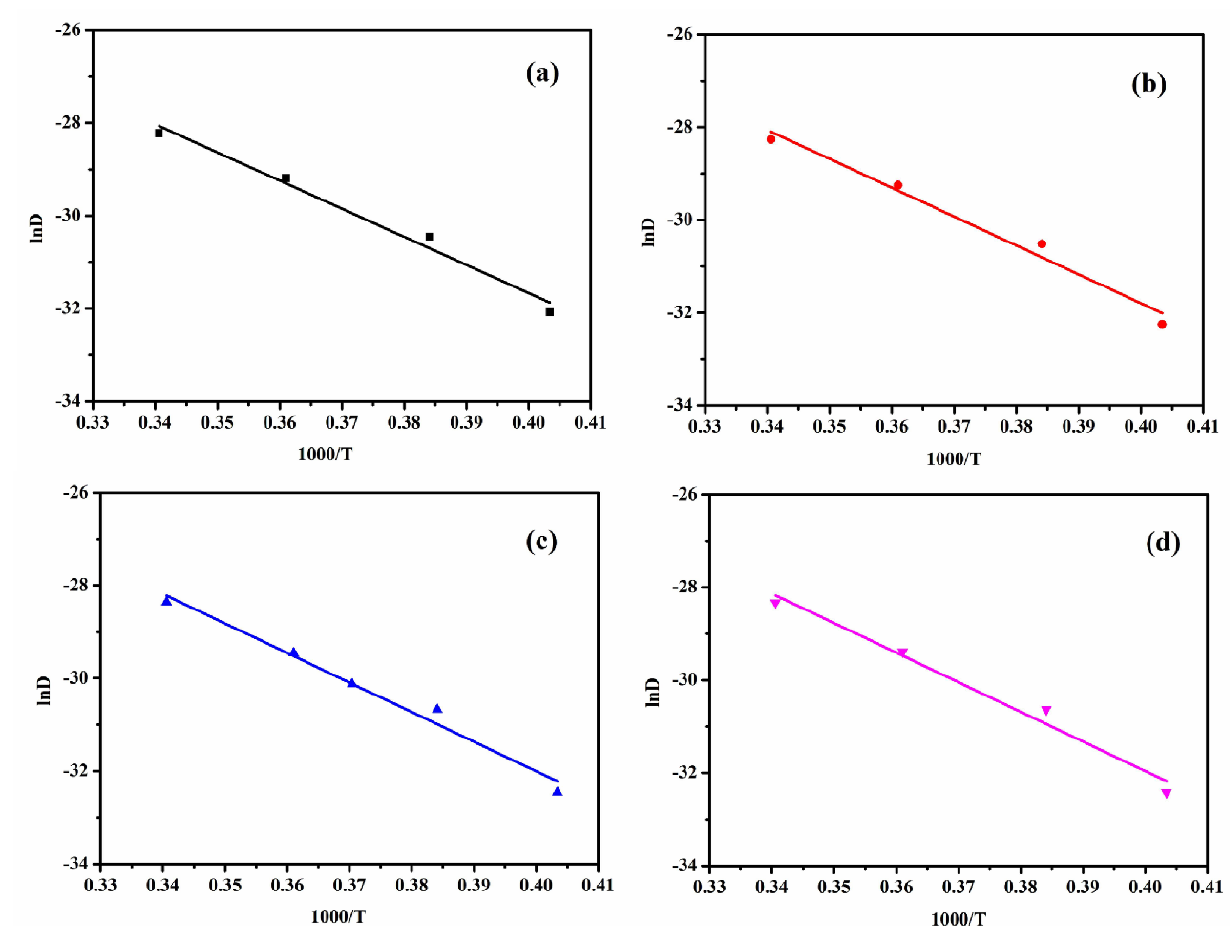
Figure 6. Linear fit of the activation energy in different insulation. ( a ) EPDM, ( b ) GO/EPDM, ( c ) HGO/EPDM, and ( d ) HGO/EPDM.